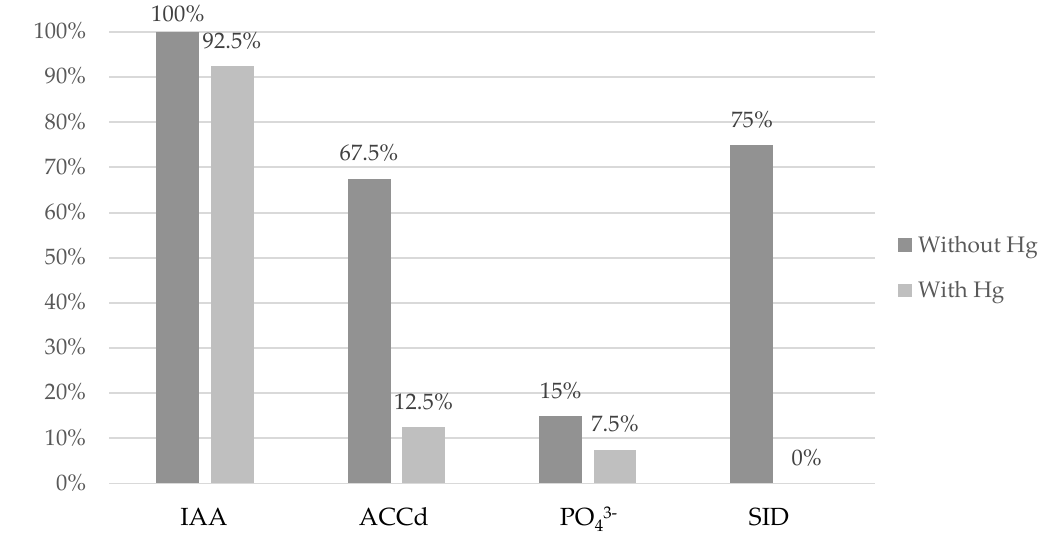
Figure 2. Percentage comparison of the data obtained by Robas et al. [11], contrasted with those obtained in the present study of the number of strains with PGPR activity at 0 µ g/mL and 100 µ g/mL of Hg. IAA: auxin producers; ACCd: ACC degraders; PO 43- : phosphate solubilizers; and SID: siderophore producers.